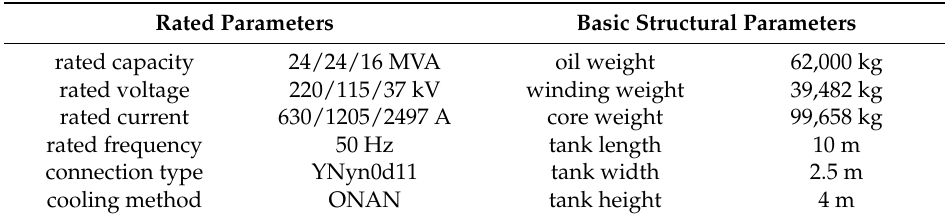
Table 1. Transformer